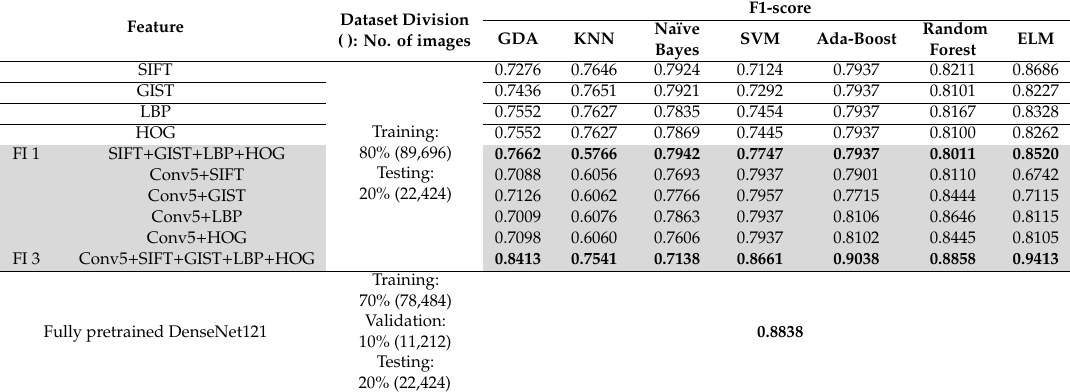
Table 2. Classification F1-scores using feature integration approach among seven classifiers.